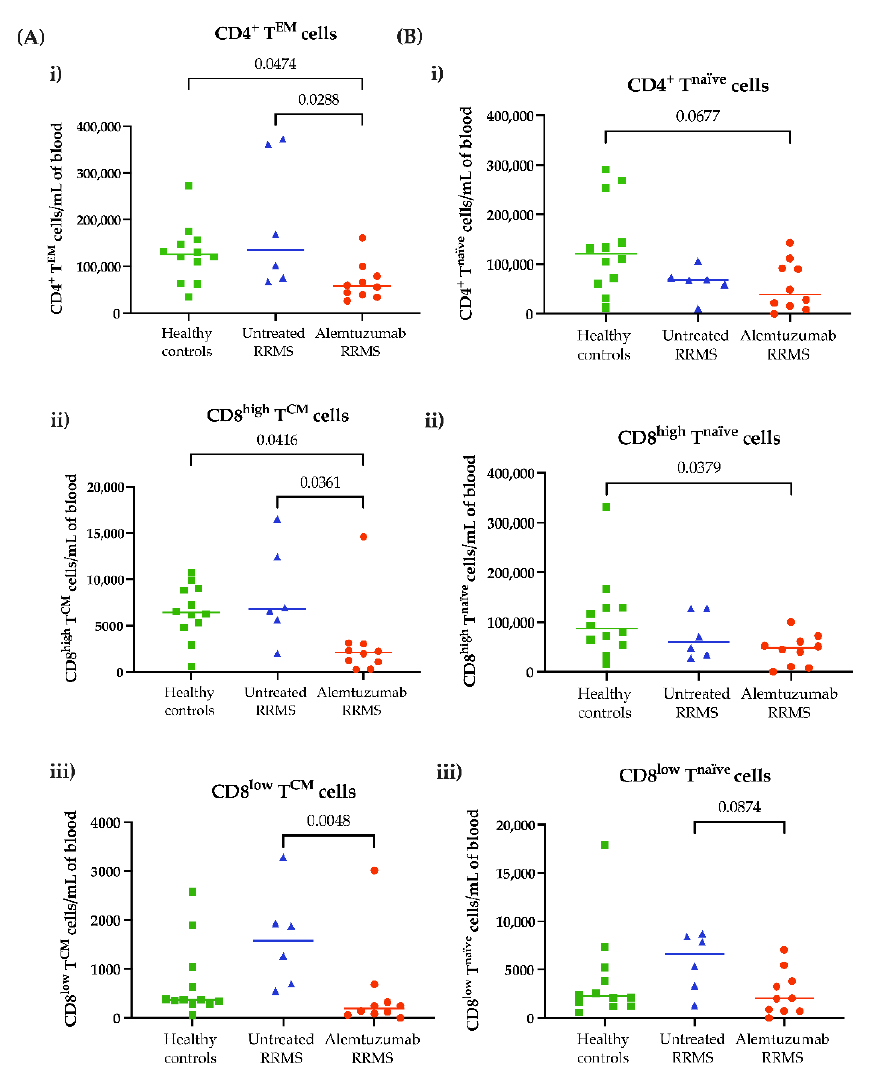
Figure 3. Alemtuzumab depletes circulating T cell subsets. Blood was sampled from healthy controls (n = 12, green squares), untreated RRMS (n = 6, blue triangles) and alemtuzumab-treated RRMS patients (n = 10, red circles). Upon sample collection, fresh PBMCs were immediately isolated and phenotyped. Each T cell subset was gated on to calculate the proportion of cells multiplied by the cell count and shown as cells per mL of blood. ( A ) The absolute number of (i) CD4 + T EM cells, (ii) CD8 high T CM cells and (iii) CD8 low T CM cells. ( B ) The absolute number of (i) CD4 + T naïve cells, (ii) CD8 high T naïve cells and (iii) CD8 low T naïve cells. Kruskal–Wallis with Dunn’s multiple comparisons test. p ≤ 0.1 are shown. T CM , central memory T cells; T EM , effector memory T cells; T naïve , naïve T cells. RRMS, relapsing-remitting multiple